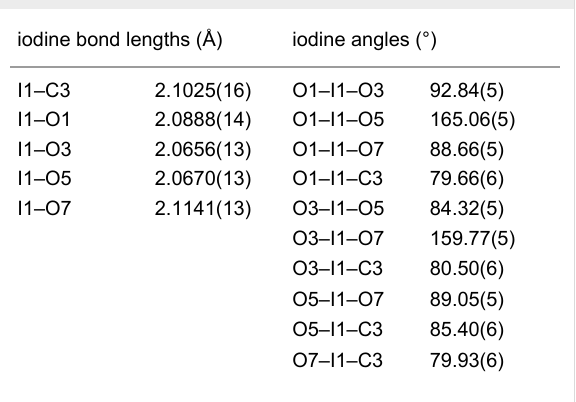
Table 1: Selected bond lengths and angles in 1